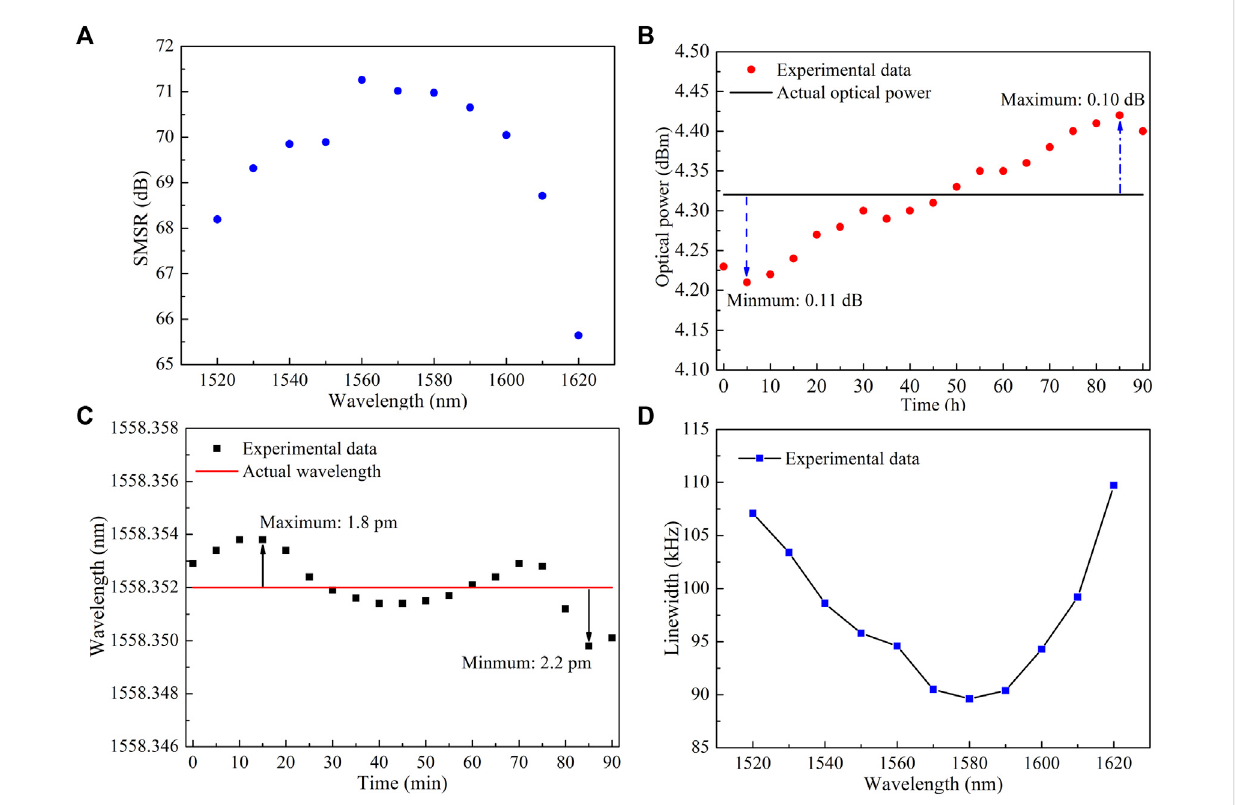
FIGURE 4 (A) Plot of the side-mode suppression ratio (SMSR) shown as the blue circles as a function of the lasing wavelength. (B) and (C) Output power and wavelength stability at wavelength 1558.352 nm with injection current of 410 mA, respectively. A variable optical attenuator is used to avoid the optical damage of the optical wavelength meter and the power meter. (D) Linewidth performance of the proposed system measured using the traditional DSH method with a total length of 24.5 km single-mode fi ber and an 80 MHz fi ber-coupled AOM. The injection current is 410